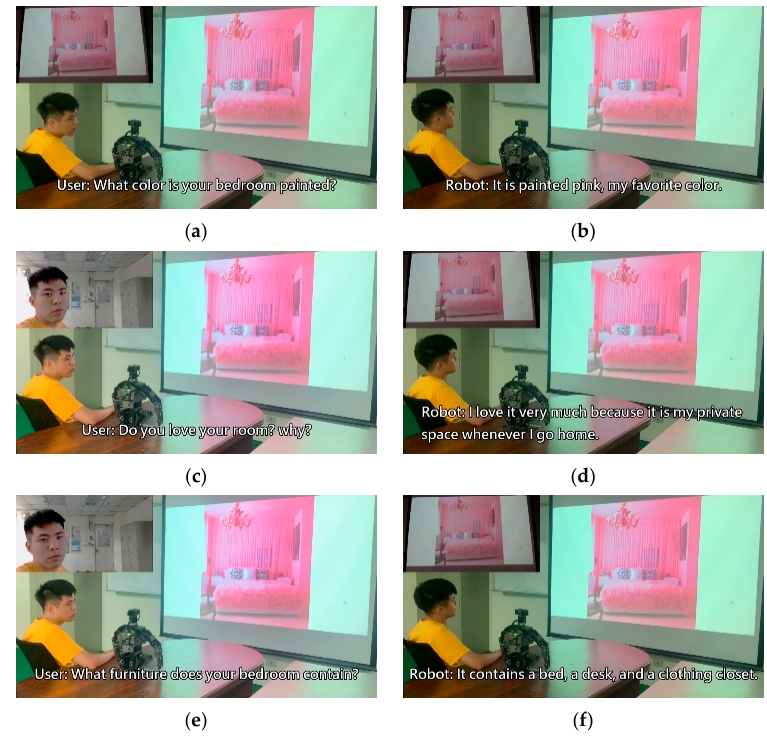
Figure 16. Experimental result in scenario D.